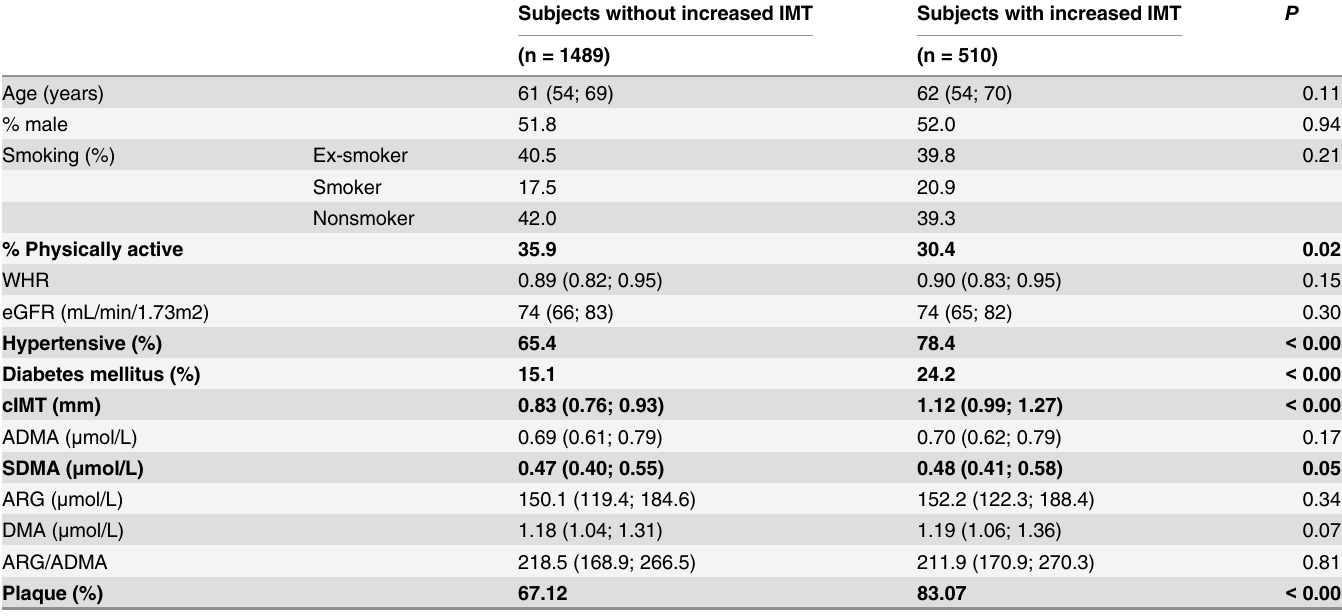
Table 1. General characteristics of the study population (median with 25 th /75 th percentile).